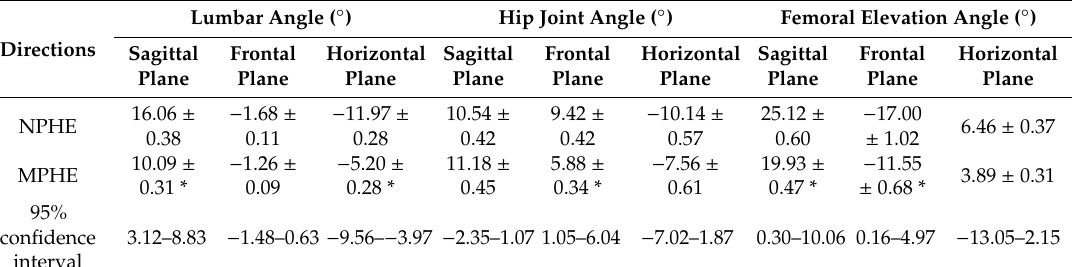
Table 2. Lumbar and hip joint angle at the maximum tilt during